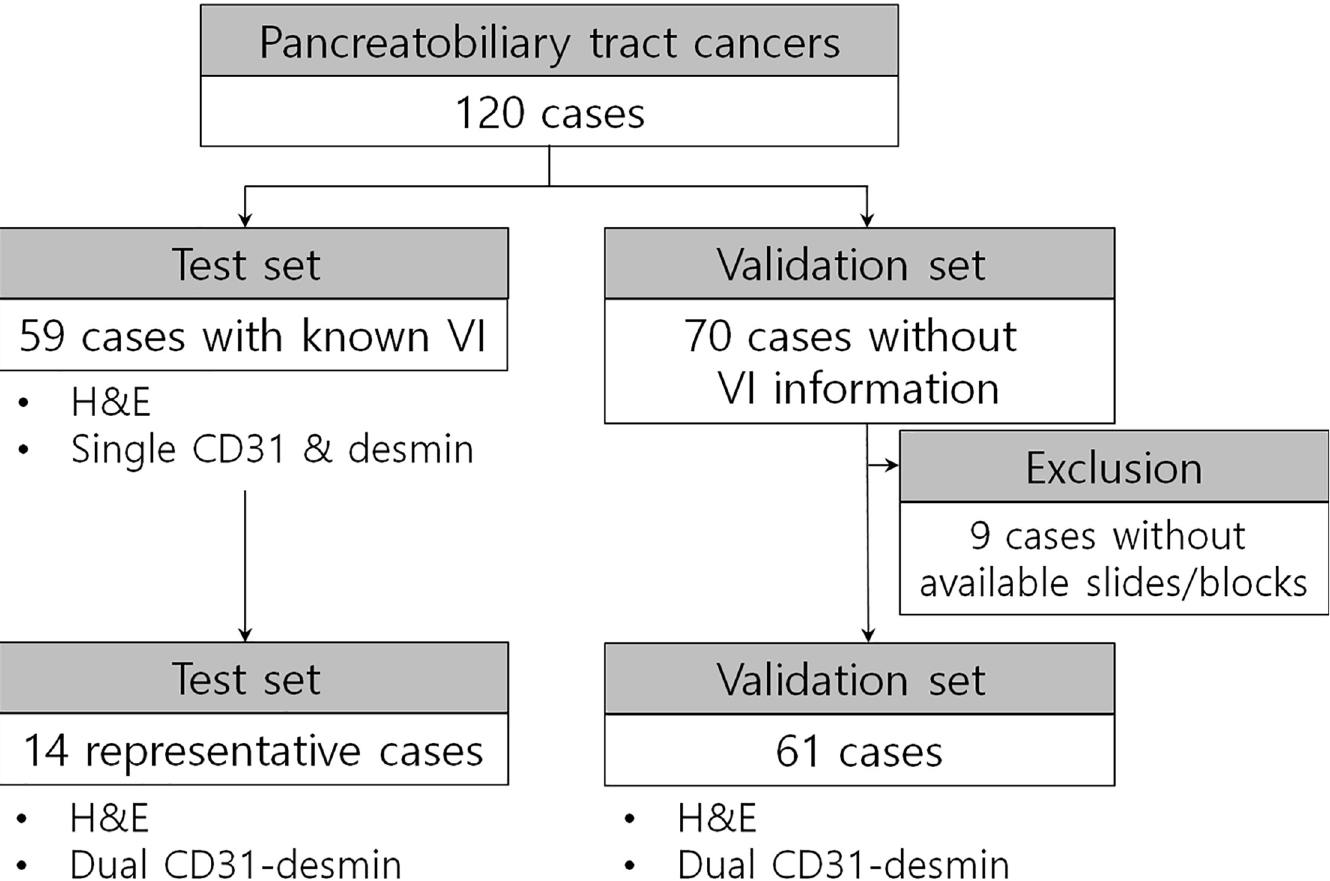
Fig 1. Flow diagram depicting the inclusion and exclusion criteria of the test and validation